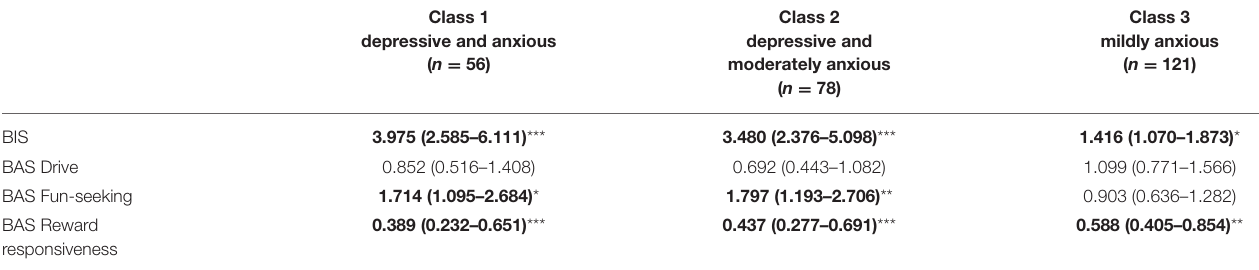
TABLE 4 | Personality risk factors predicting class membership: odds ratios and 95% confidence intervals from multinomial logistic